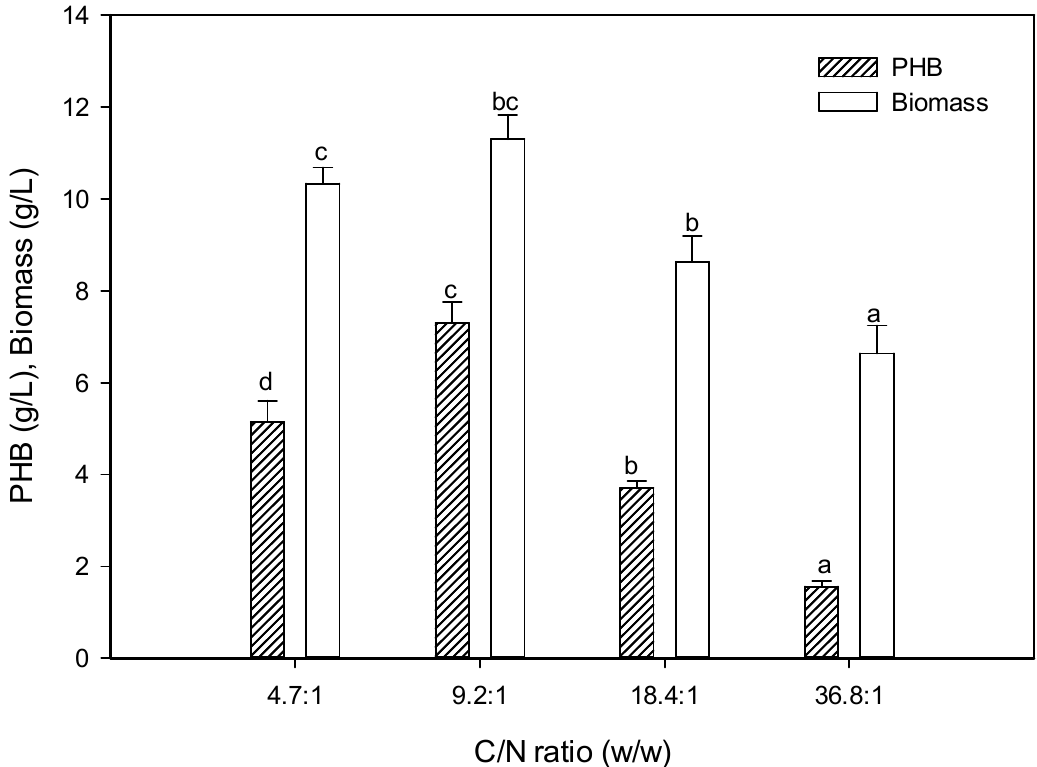
Figure 10. Effect of C:N ratio on the PHB production by E. aquimaris . The values set by oneself letter(s) on the same column were not significantly different.